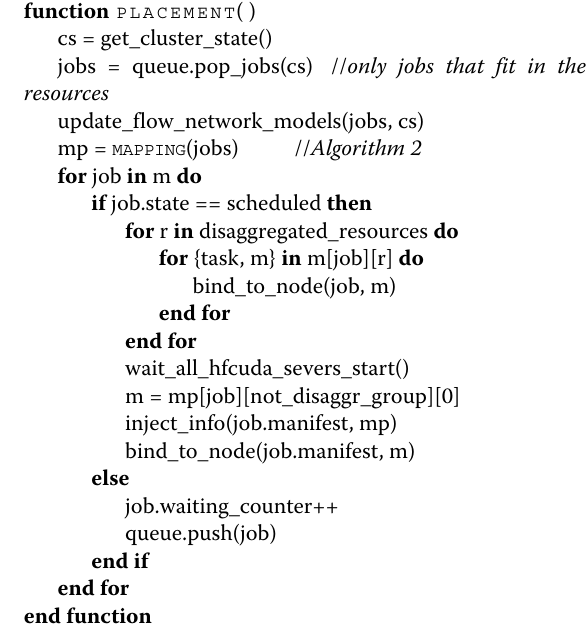
Algorithm 1 DRMaestro Placement